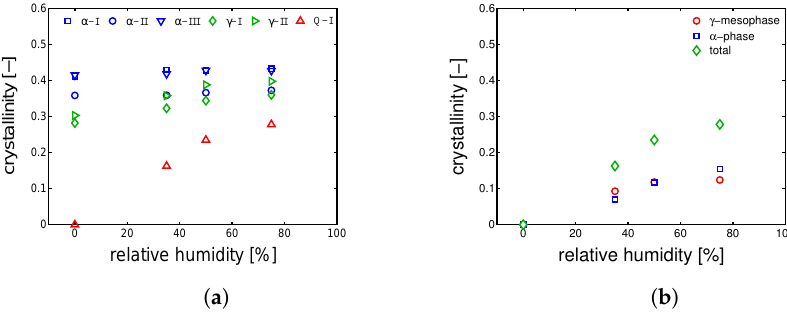
Figure 13. ( a ) overall crystallinity values as functions of relative humidity (conditioning performed at 23 °C); ( b ) evolution of the crystallographic phase contents as functions of relative humidity (conditioning performed at 23 °C) starting from Q-I (amorphous)